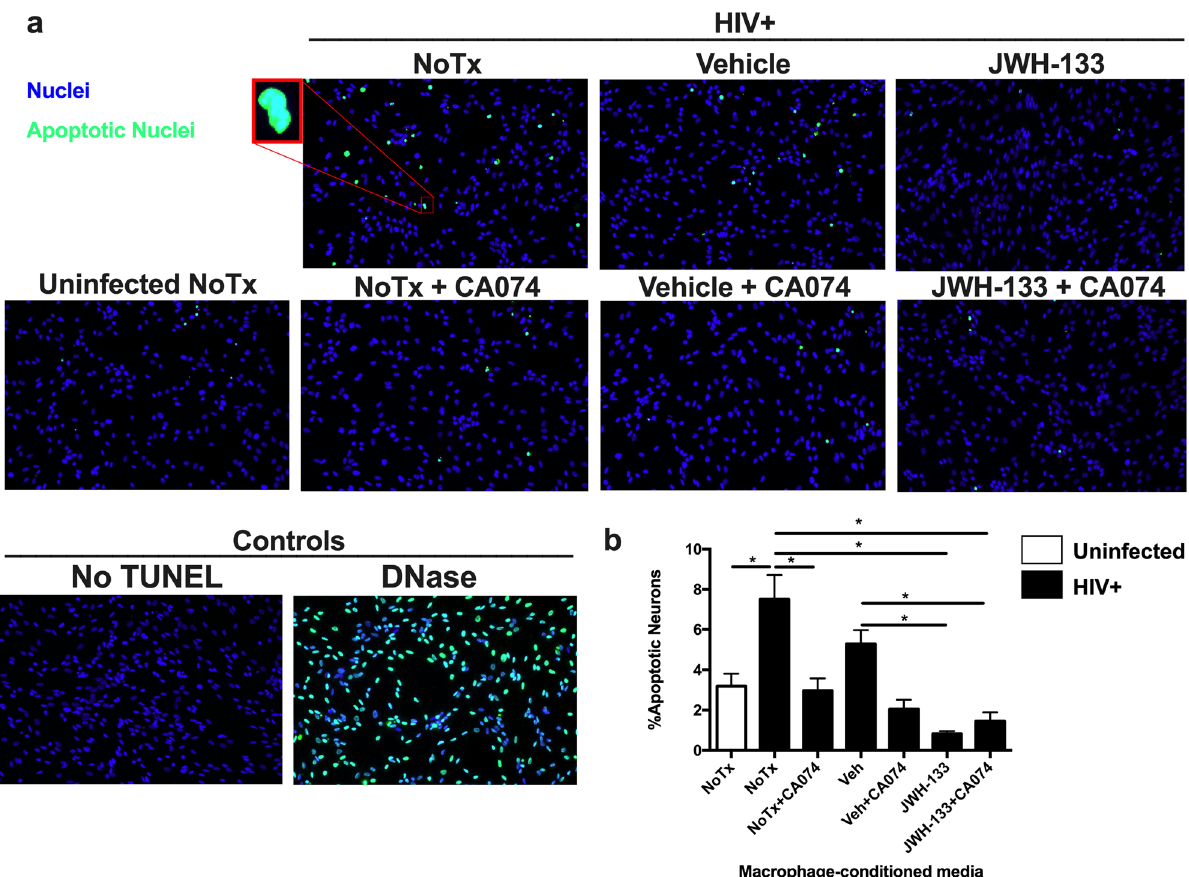
Figure 5. JWH-133 decreases HIV/MDM-induced neuronal apoptosis and CATB neurotoxic potential. Uninfected and HIV-infected MDM were untreated or treated with vehicle and JWH-133 (0.5 µM) for 12dpi. On day 13pi, MCM from donors that had increased CATB secretion after HIV-1 infection compared to the uninfected control were used to determine the effect of JWH-133 treatment in HIV/MDM-induced neuronal apoptosis and CATB neurotoxic potential. ( a ) Representative immunofluorescence images of human neuroblastoma cells that were exposed to MCM in the presence or absence of the CATB inhibitor, CA074. Cyan fluorescence indicates TUNEL positive cells (apoptotic neurons), whereas nuclei stained with DAPI are shown in blue. DNase and No TUNEL were included as positive and negative controls, respectively. ( b ) Cyan and blue nuclei were counted in at least 3 random fields per condition and results are shown as %Apoptotic Neurons. This figure is representative of four different donors (n = 4). Graphs are presented using the mean and the ± standard error of the mean (SEM). * p <